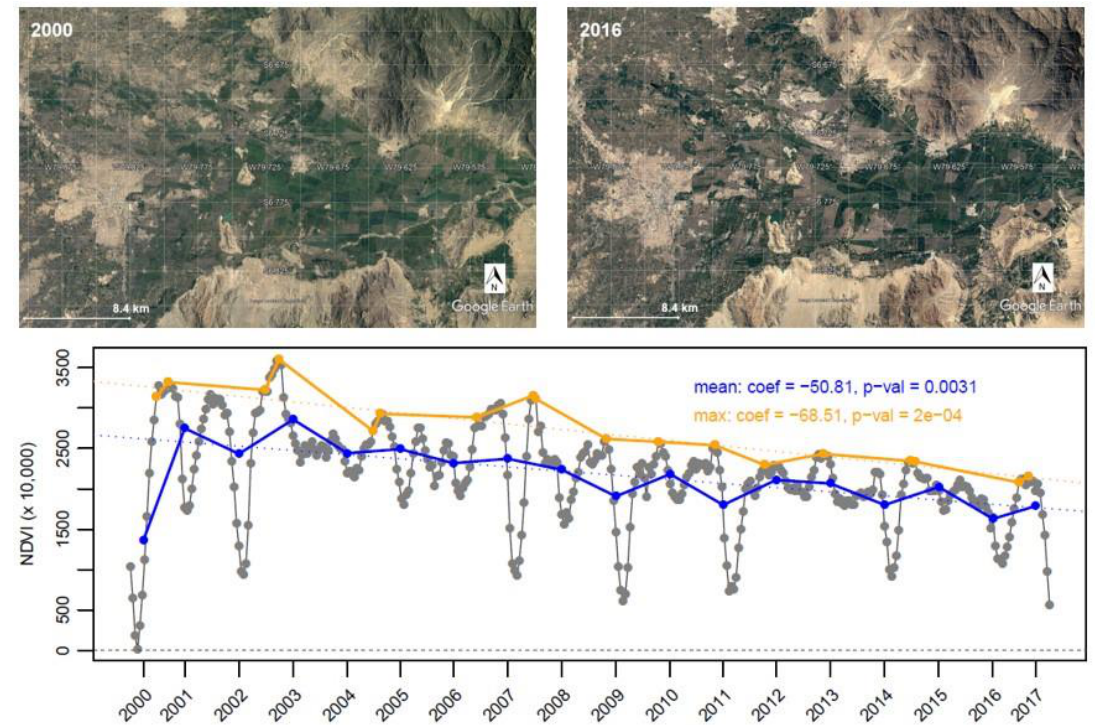
Figure 15. In the upper panels, high spatial resolution imagery from Google Earth Pro shows Dry Coast browning near Lambayeque between 2000 and 2016. Where urban centers expand into agricultural zones, a loss of vascular plant material results in browning trends. The accompanying graph shows the entire time-series of the NDVI data and fitted Thiel-Sen trends for NDVI-mean (blue) and NDVI-maximum (orange) for a pixel located at S 6.762088 ◦ , W 79.727939 ◦